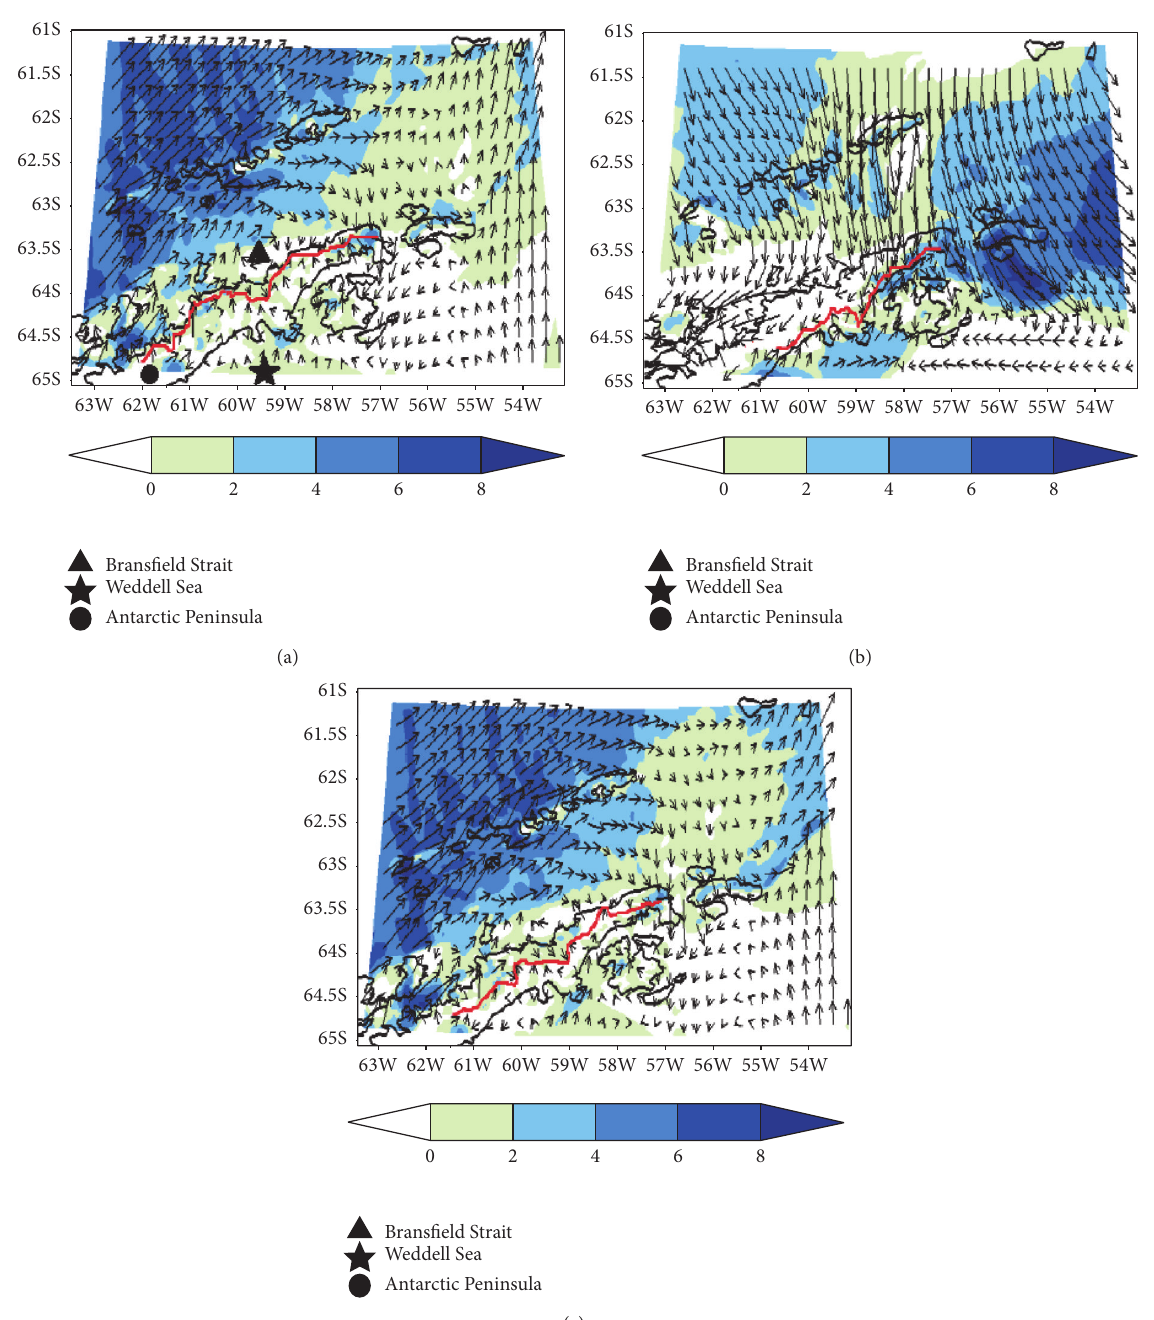
Figure 5: 10m wind vectors and wind speed (m/s, color legend) for the following: (a) 29 December 2014 at 16:00 UTC; (b) 24 December 2013 at 12:00 UTC; (c) 29 December 2014 at 18:00 UTC, simulated with WRF. The red line marks the sea breeze convergence.